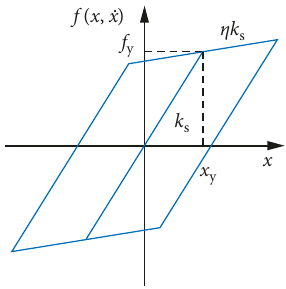
Figure 14: Bilinear hysteresis